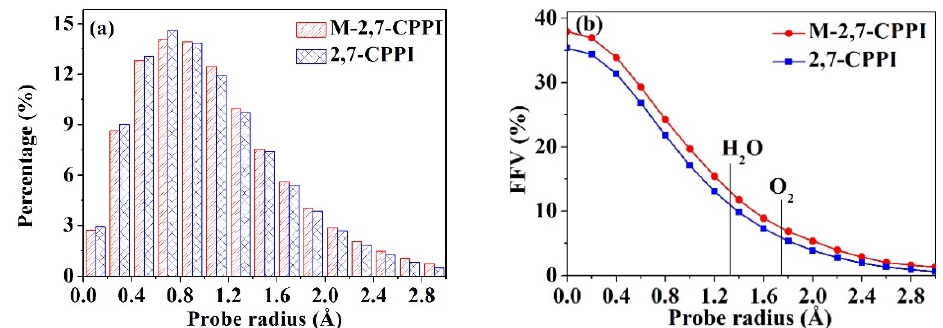
Figure 8. Distributions of void radius ( a ) and fractional free volume ( b ) as a function of probe radius in M-2,7-CPPI and 2,7-CPPI. The kinetic radii of O 2 and H 2 O are indicated by vertical lines.